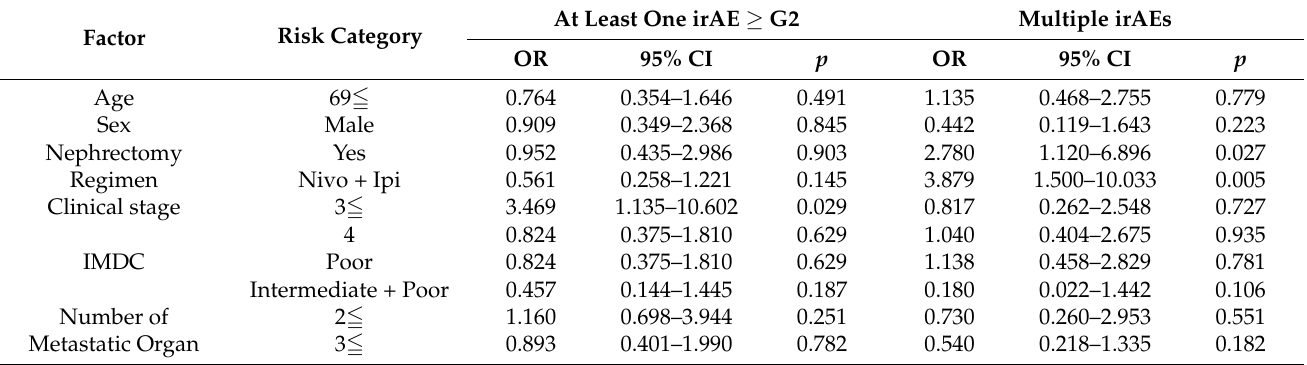
Table 4. Association between adverse events and clinical factors and polymorphisms in PDCD1